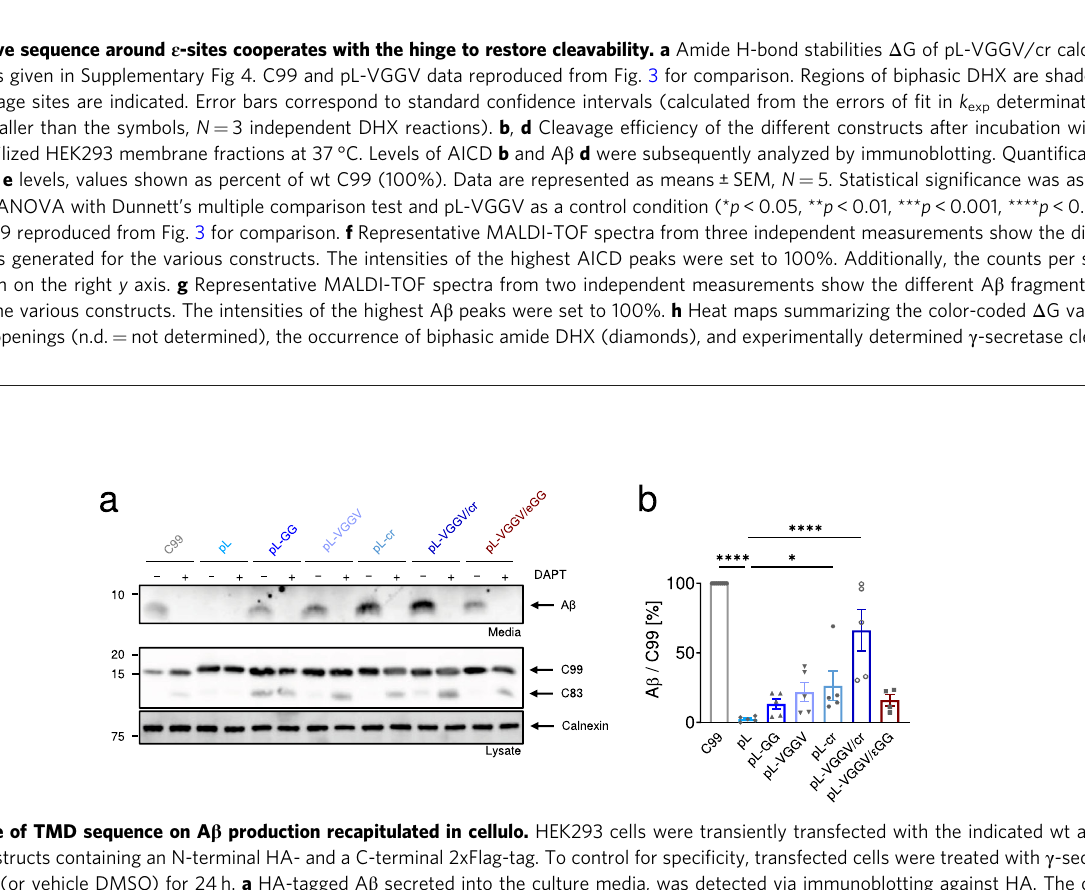
Fig. 5 The native sequence around ε -sites cooperates with the hinge to restore cleavability. a Amide H-bond stabilities Δ G of pL-VGGV/cr calculated